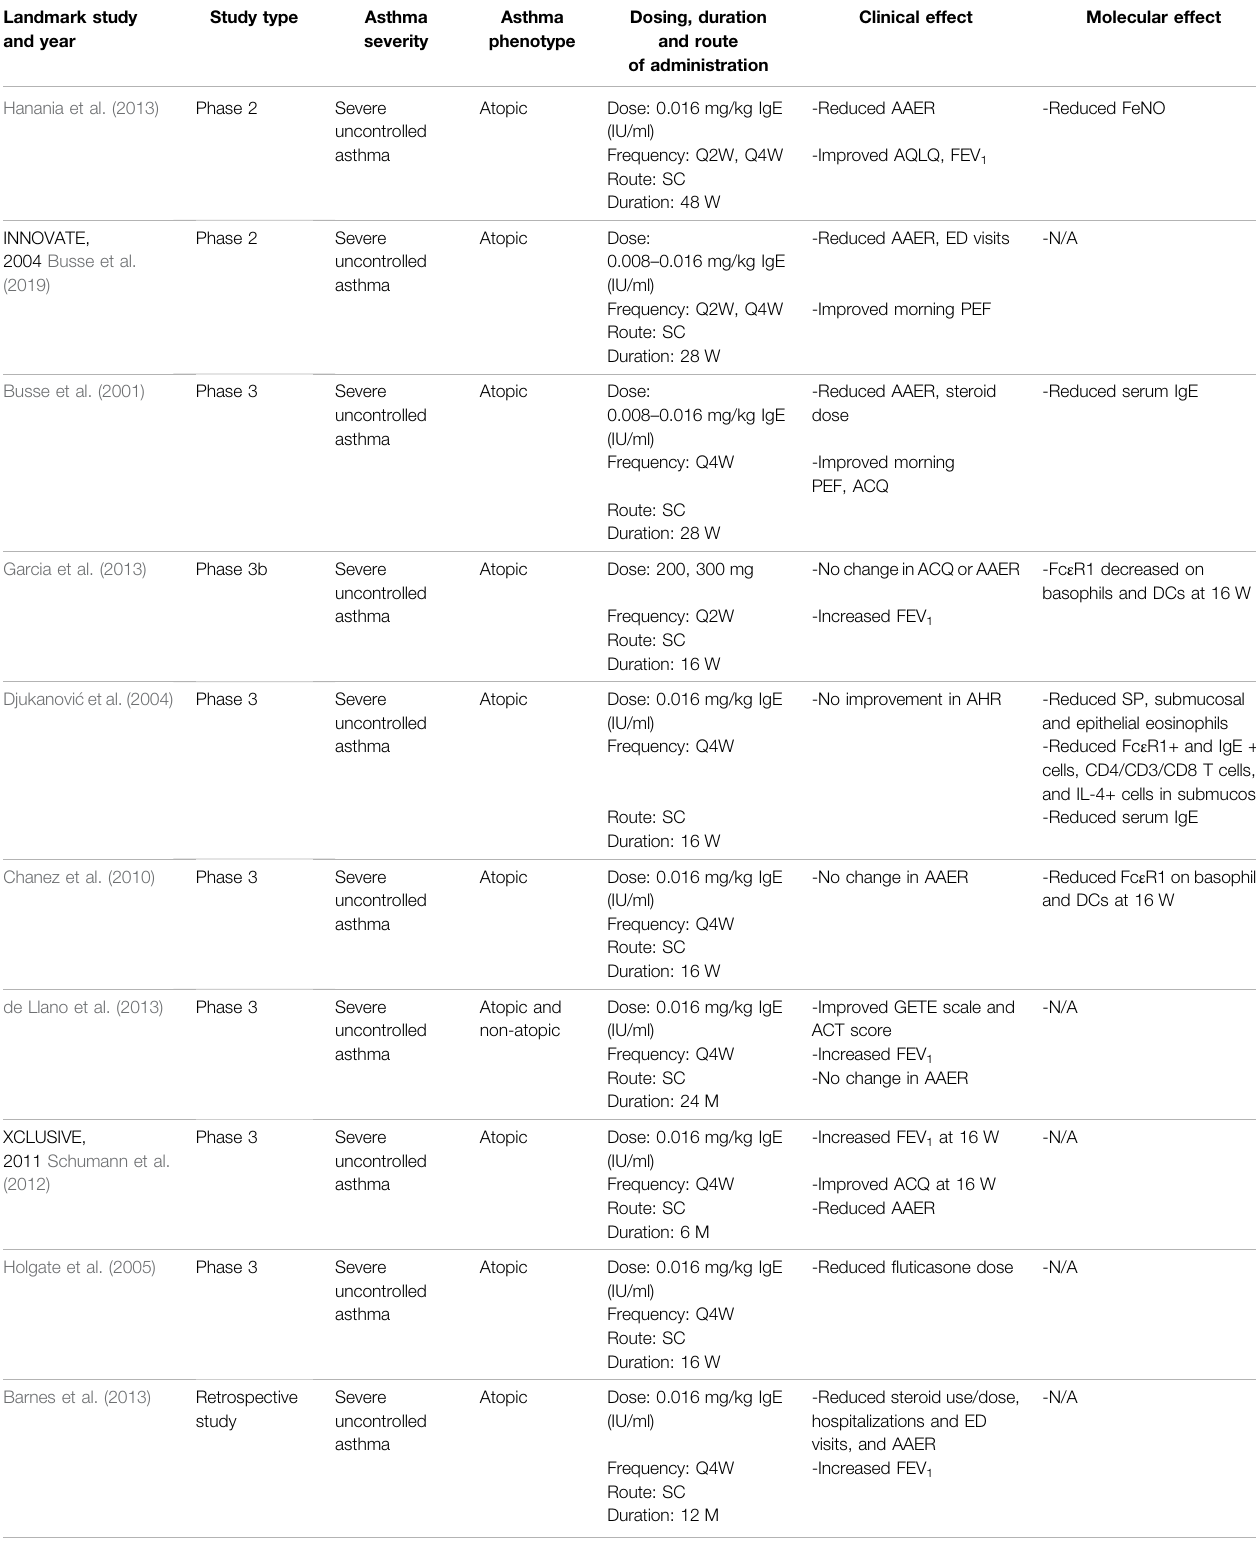
TABLE 1 | Summary of anti-IgE targeted randomized clinical trials in severe